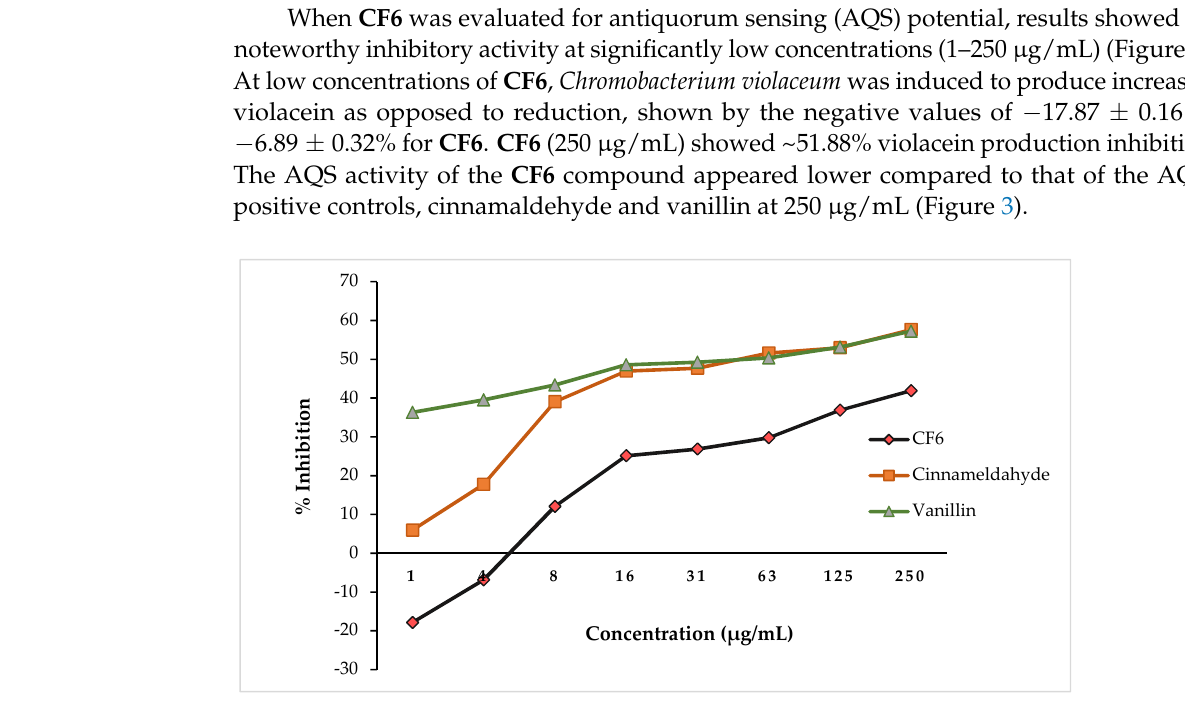
Figure 3 . CF6 vs. cinnamaldehyde and vanillin showing anti-quorum sensing potential in a concentration-dependent manner (1–250 µg/mL).